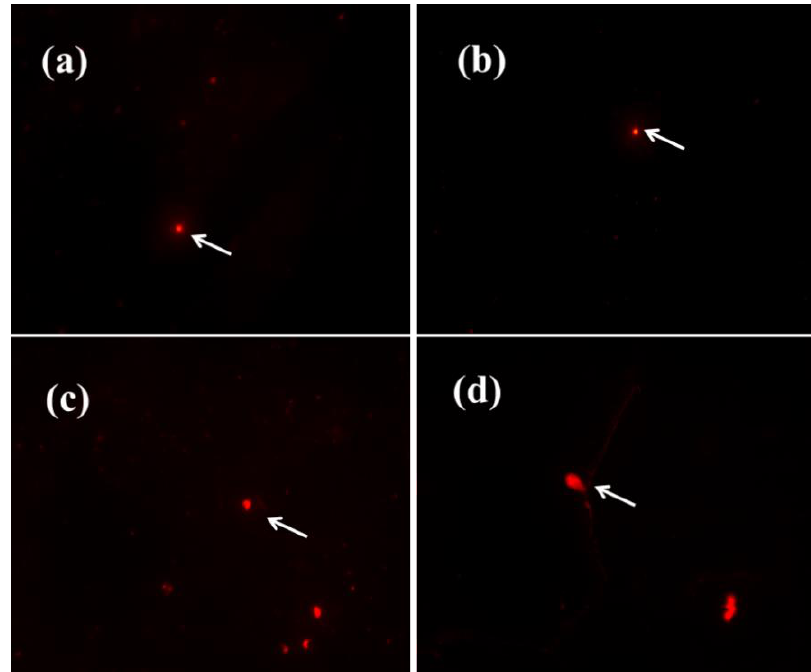
Figure 9. Comet experiment results. ( a , b ) Control group, ( c , d ) 500 μg/mL.